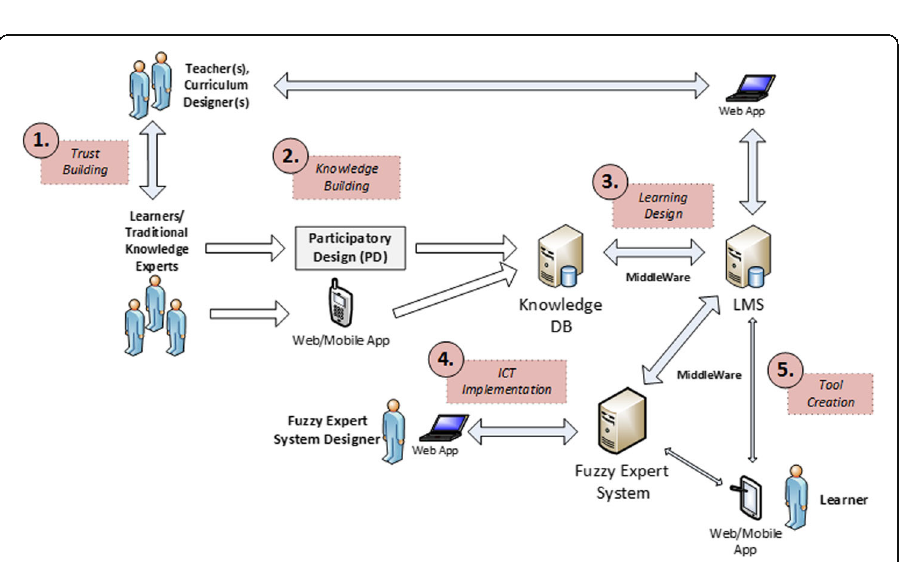
Fig. 1 The I-SLATE framework (Revised from Authors